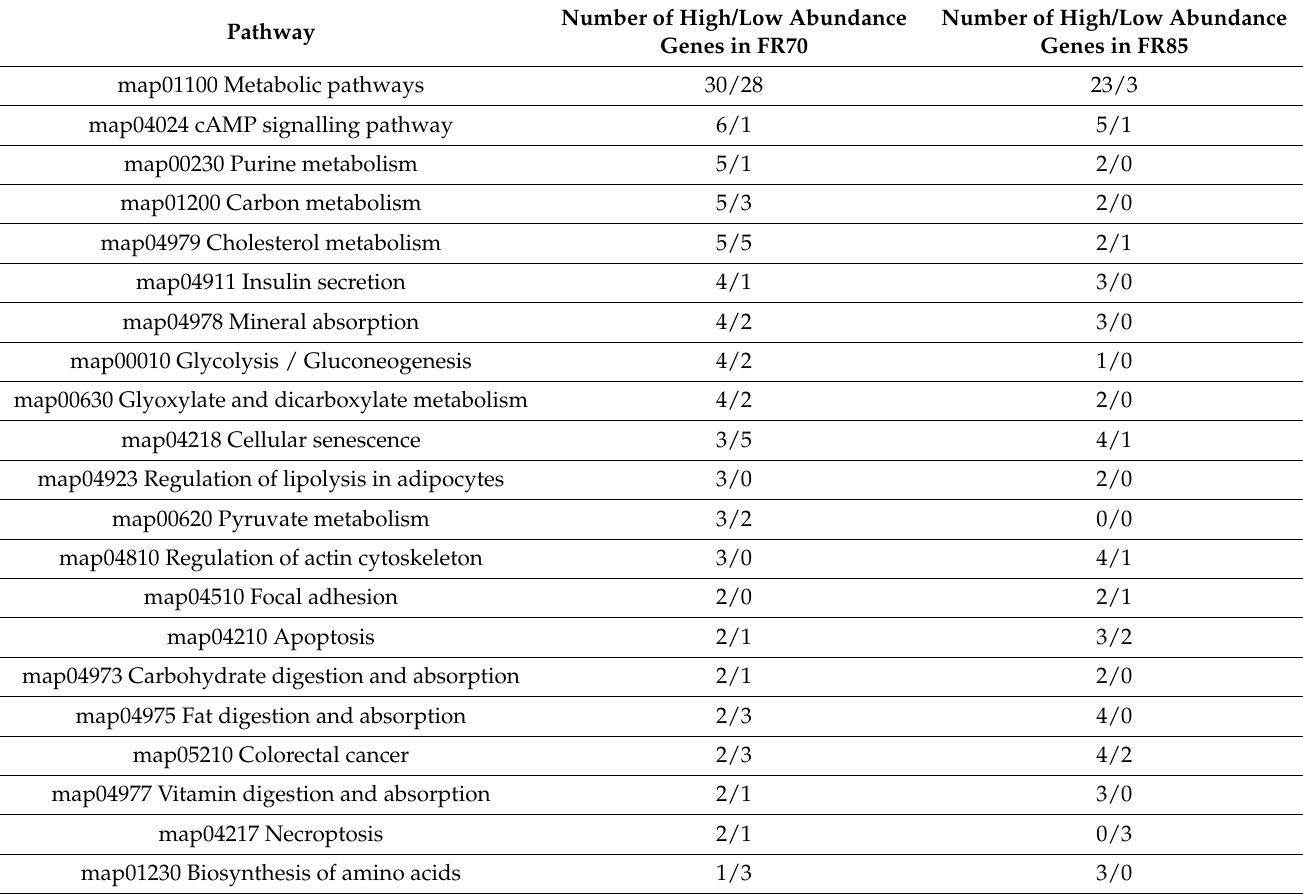
Table 2. Significant ( p < 0.05) pathways characterized by Kyoto Encyclopedia of Genes and Genomes (KEGG) analysis of differentially expressed genes from 70% and 85% FR groups. The numbers of genes mapped to annotated pathways are